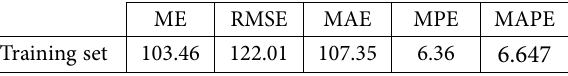
Table 2. Selected forecast errors of the naive